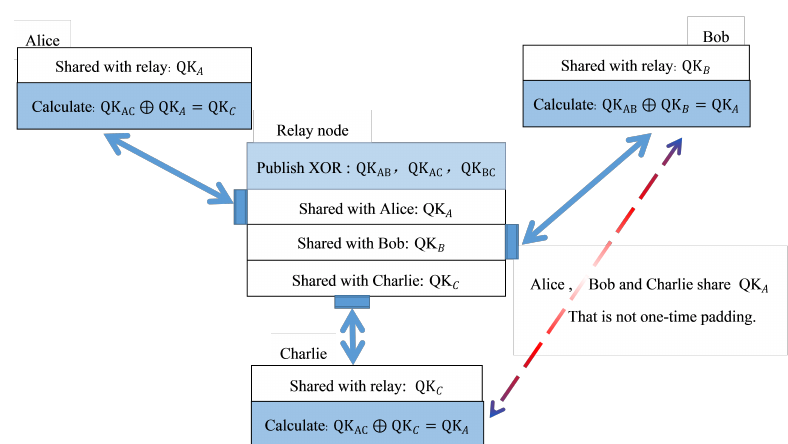
Figure 3. The communications of three endpoints with Protocol 2 with repeated keys. The solid line stands for the QKD process. The relay node calculates and publishes Qk AB = Qk A ⊕ Qk B , Qk AC = Qk A ⊕ Qk C , Qk BC = Qk B ⊕ Qk C , and then dismisses the QKD keys immediately. The